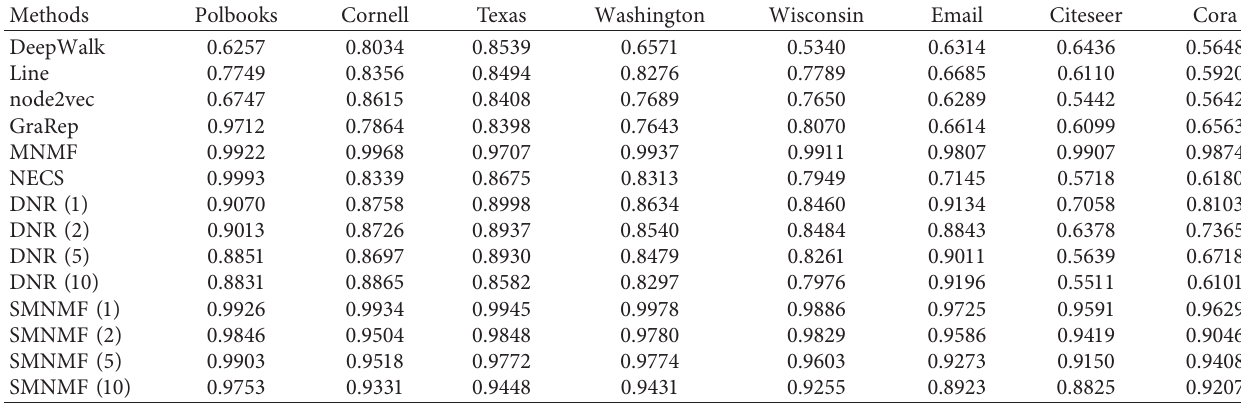
Table 5: AUC-ROC of link prediction (80% training set and 20% test set).